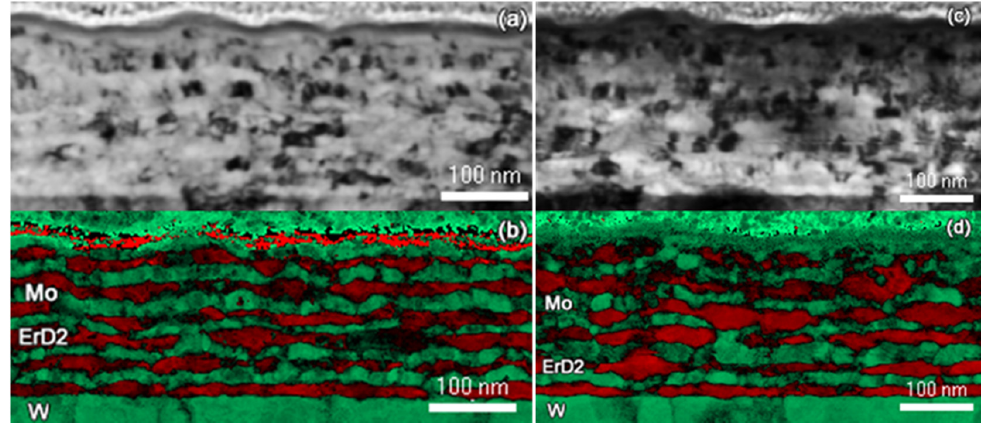
Figure 2. ACOM data of the as-deposited ( a , b ) and deuterated ( c , d ) Er/Mo multilayers. The top images ( a , c ) show the virtual BF image calculated from the ACOM data, while the bottom images ( b , d ) show the overlay of the index map, Mo and W in green and ErD 2 in red.